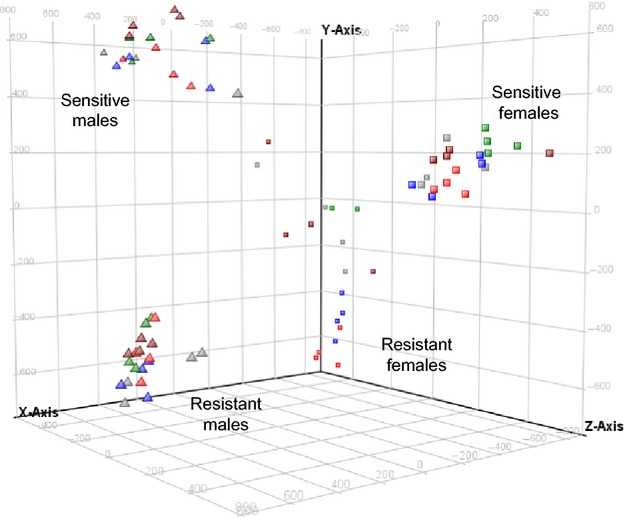
Principal component analysis of samples based on gene expression. Male and female lice samples separated along the x-axis (PC1: 40.9% of variation), and populations separated by y- and z-axes (PC2: 28.3% and PC3: 20.7%, respectively). A separation of emamectin benzoate (EMB) doses is identifiable in the resistant females only. Colors display EMB concentration (red = 0; blue = 0.1; gray = 25; green = 300; brown = 1000), and shape displays the sex (triangle = male; square = female); population is labeled beside each cluster.